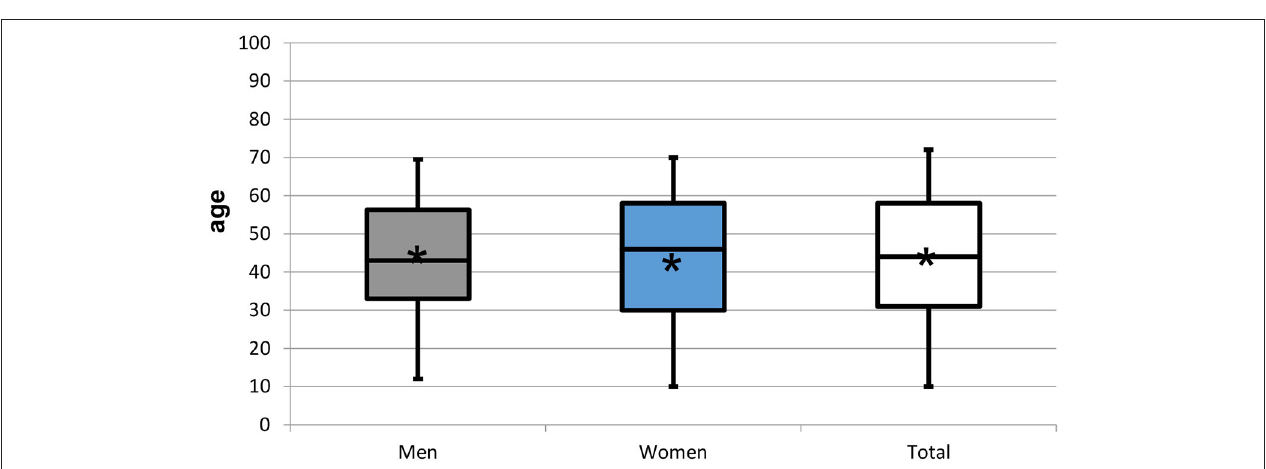
FIGURE 2 | Box plots representing the age distribution by gender of the 952 patients experiencing orofacial pain and dysfunction. Star symbol (*) indicates mean.